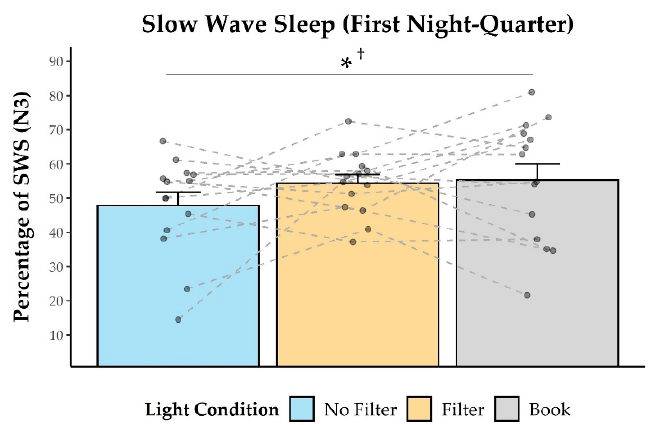
Figure 5. Time in slow wave sleep (N3; in %) during the first night-quarter. Participants spent less time in SWS in the “No Filter” than in the “Book” condition in the first night-quarter. * = p ≤ 0.05; † = p adj. >